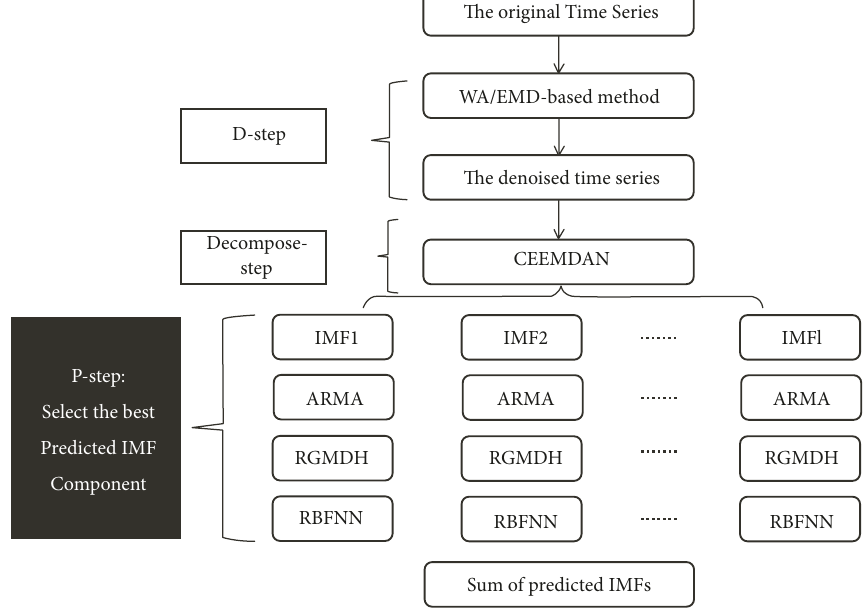
Figure 1: The proposed WA/EMD-CEEMDAN-MM structure to predict hydrological time series